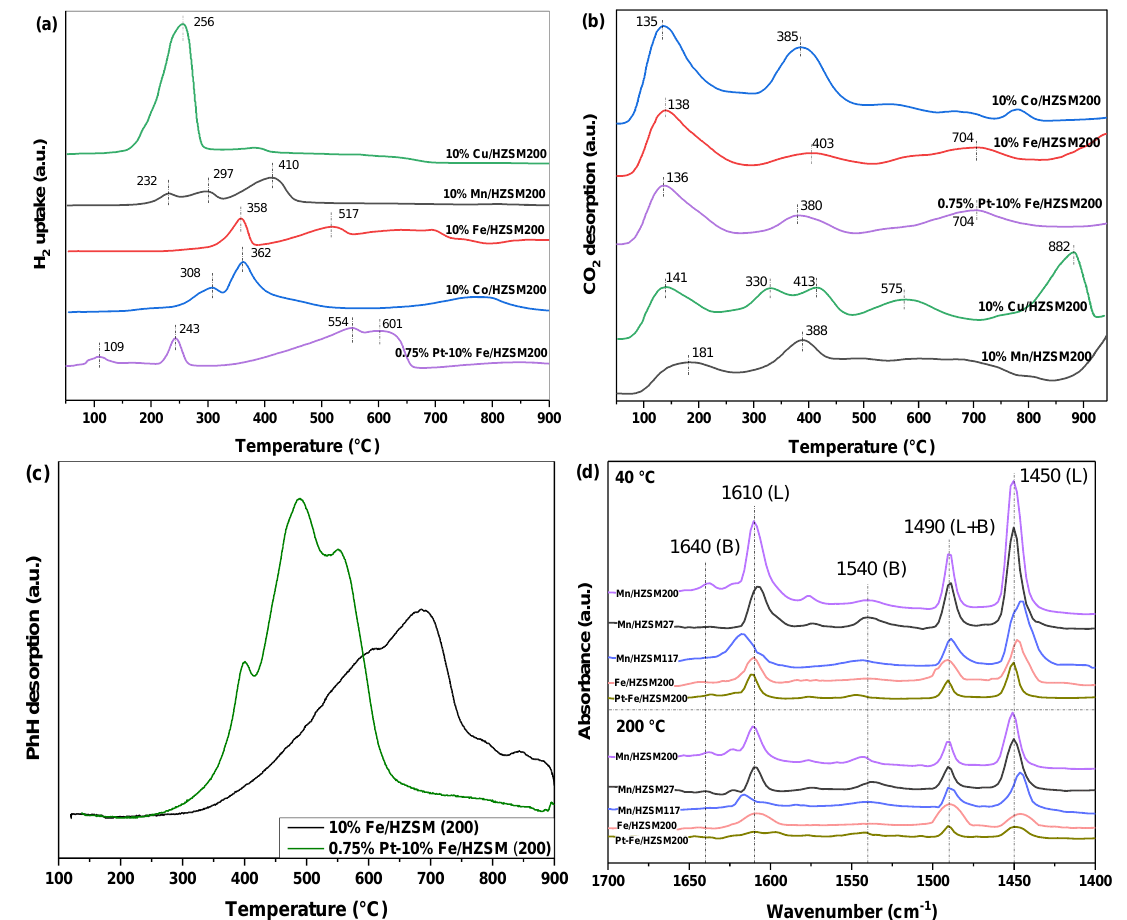
Figure 6. H 2 − TPR ( a ), CO 2 − TPD ( b ), C 6 H 6 − TPD ( c ), and Py − IR ( d ) profiles of the catalysts. Table 5. H 2 uptake from the H 2 − TPR profiles of the different catalysts. Fir. Red. Peak Sec. Red. Peak Thir. Red. Peak H 2 Uptake Catalysts